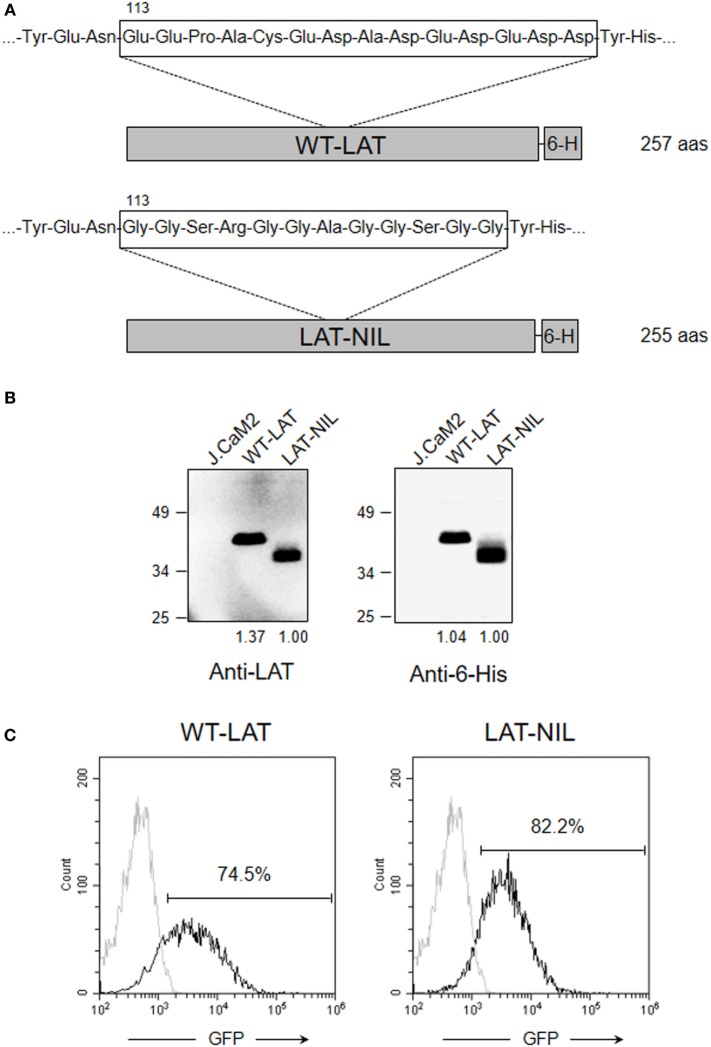
Expression of WT-LAT and LAT-NIL in J.CaM2 cells. (A) Schematic representation and amino acid sequence of the negatively charged stretch in WT-LAT or the substituting sequence in LAT-NIL mutant. (B) J.CaM2 and lentivirally transduced J.CaM2 cells expressing WT-LAT or LAT-NIL mutant were lysed, and linker for activation of T-cell (LAT) expression was analyzed by Western blot with anti-LAT (left panel) or anti-6His (right panel). Molecular masses in kilodaltons are indicated on the side of the Western blots. Numbers below the blots indicate relative densitometric quantification of the bands. Images are representative of four independent experiments. (C) Histograms of GFP expression in J.CaM2 and lentivirally transduced cells expressing WT-LAT or LAT-NIL. Histograms are representative of four independent experiments.